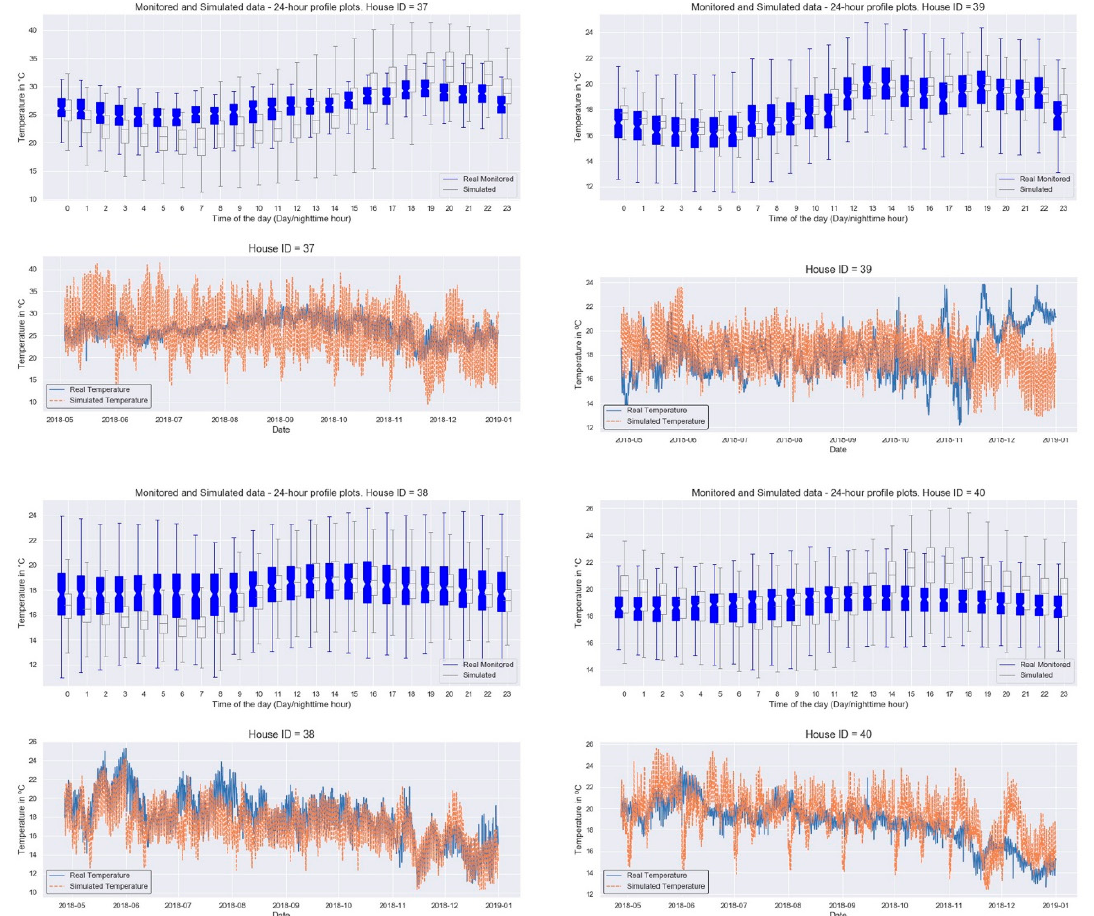
Figure A5. Visual results of the calibration of the models used for simulation—page 5.